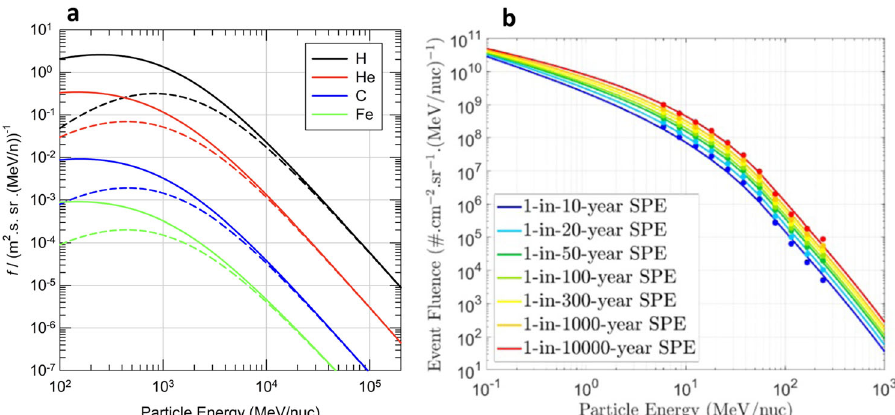
Fig. 1 Energy spectrum of space radiation. a The galactic cosmic radiation spectrum in free space for solar maximum (dashed line) and solar minimum (solid line) conditions as calculated with the DLR GCR Model 47 for four different ions. Figure from the DLR image database b The solar energetic particle radiation fl uence environment in free space for rare “ extreme ” events as calculated with the SAPPHIRE Model 48 . The model shows that more intense and energetic events are more seldom (the lines correspond to events occurring with a mean frequency of 1- in-N years). Figure produced by ESA-ESTEC using the SAPPHIRE-network of models